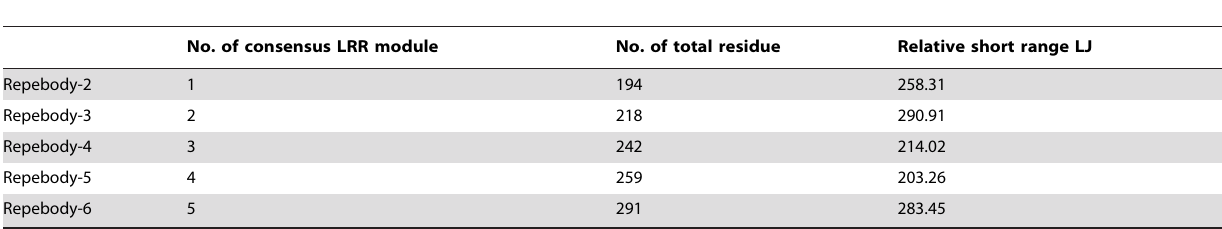
Table 3. Relative short rang LJ energy values for selection of optimized VLR module protein.